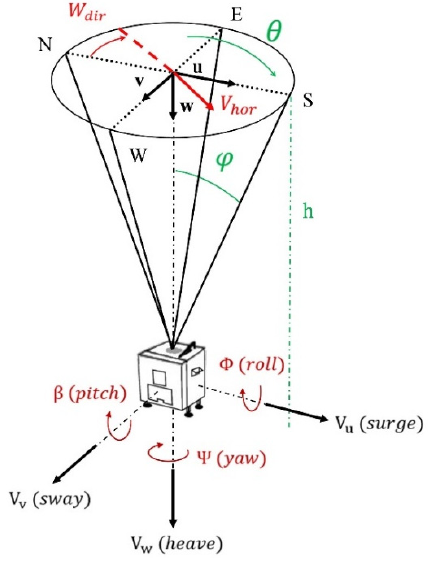
Figure 1. WindCube v2 ® pulsed LIDAR principle and the six degrees of freedom of buoy-induced motion.